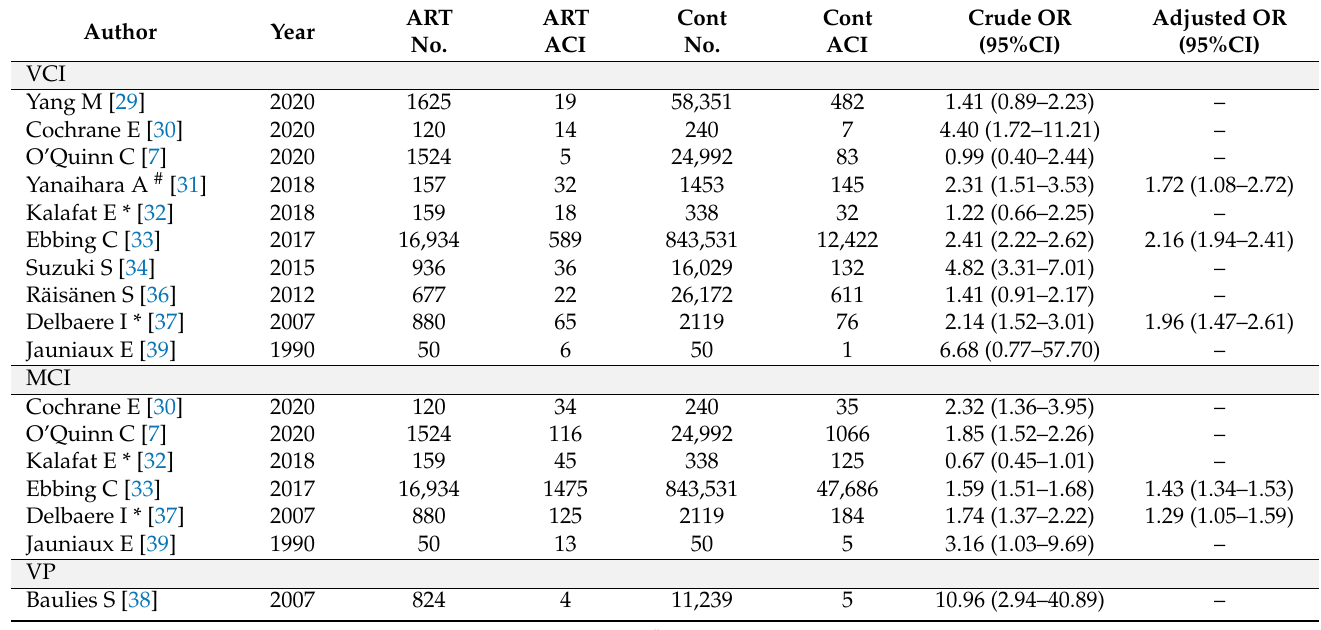
Table 1. The association between ART and